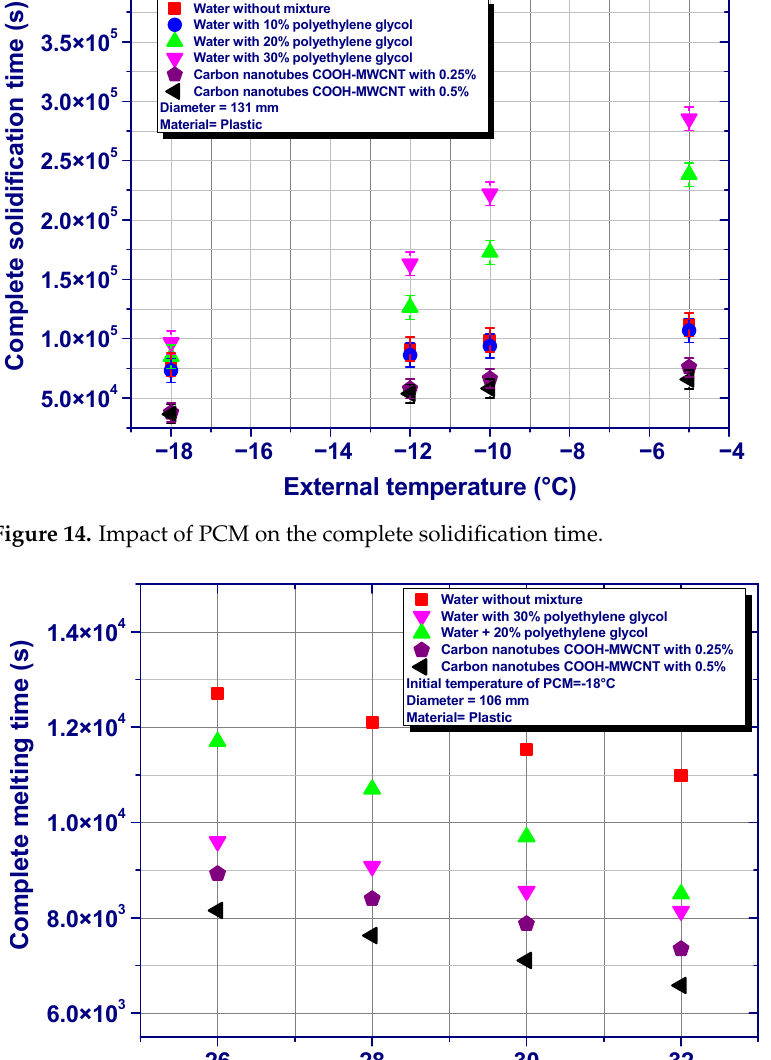
Figure 14. Impact of PCM on the complete solidification time.